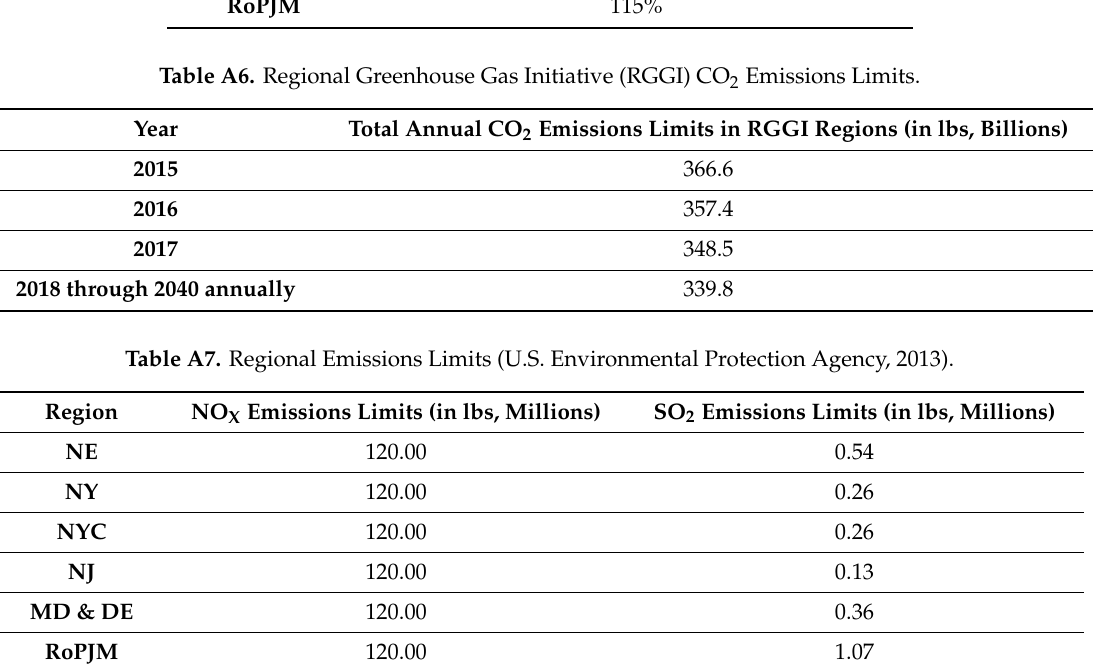
Table A8. Annual Emissions Limits (U.S. Environmental Protection Agency, 2013).